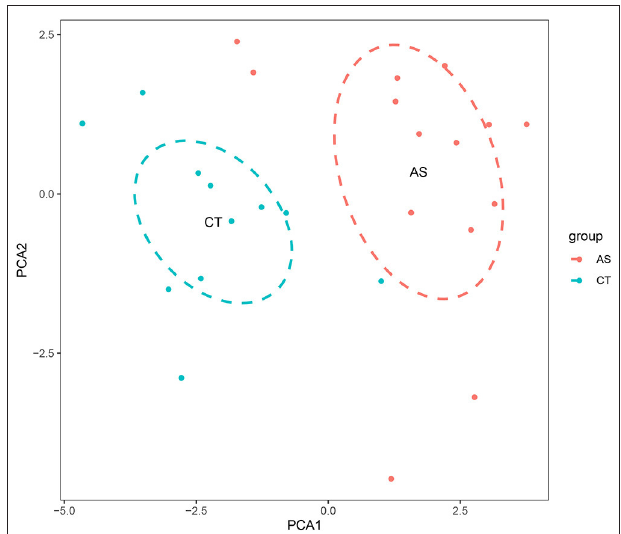
FIGURE 2 | A principal component analysis (PCA) is performed on normal and atherosclerotic arteries. The first two principal components explaining the most data variation are